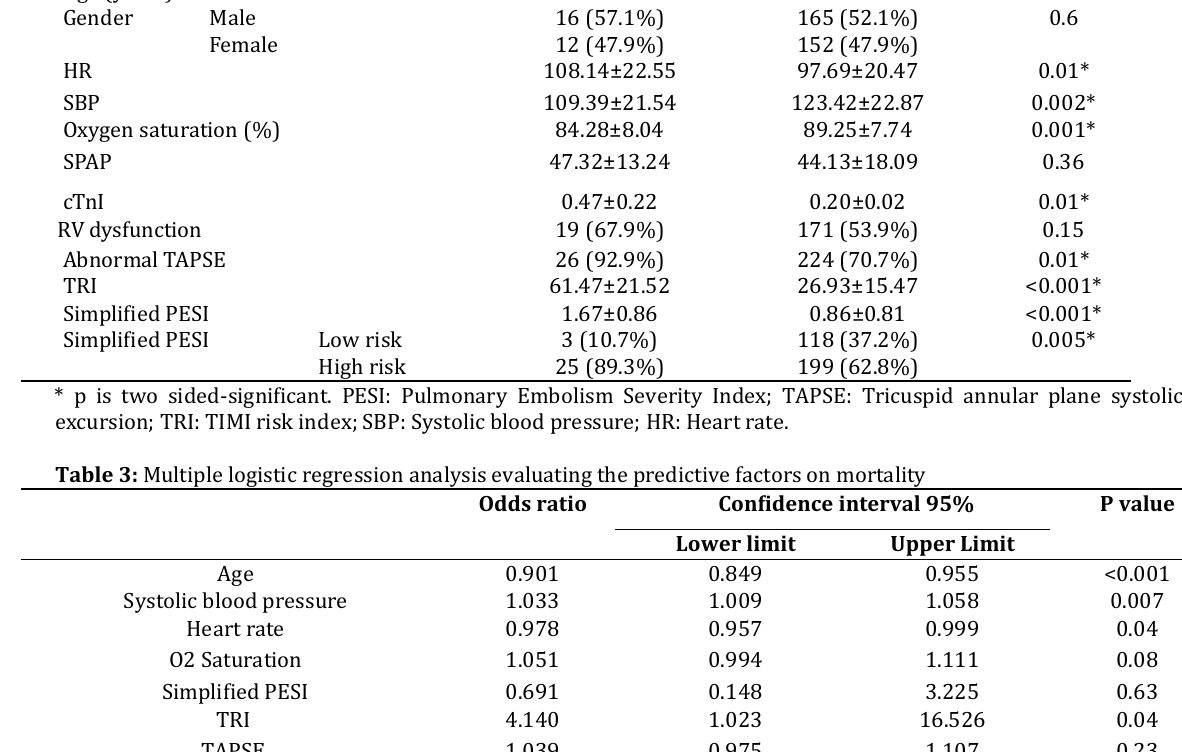
Table 2 : Baseline and in-hospital findings between patients with and without in-hospital mortality Mortality group